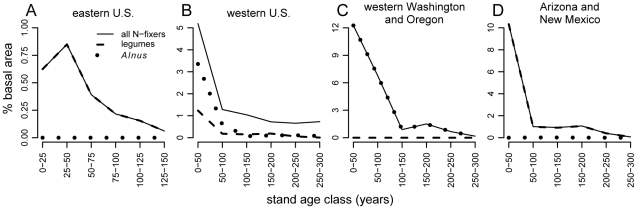
Mean percent basal area of N fixers vs. stand age.(A) Eastern and (B) western U.S. (coterminous U.S. east and west of 100° W longitude, respectively), (C) western Washington and Oregon (all counties west of the crest of the Cascade Mountains), and (D) Arizona and New Mexico. Basal area was calculated using FIA data, with 107,705; 28,454; 793; and 8,274 plot records, respectively, for panels A, B, C, and D. The dashed and dotted lines in B do not sum to the solid line because additional actinorhizal N-fixing taxa (e.g., Cercocarpus spp.) are present in the western U.S. (see Table S1).